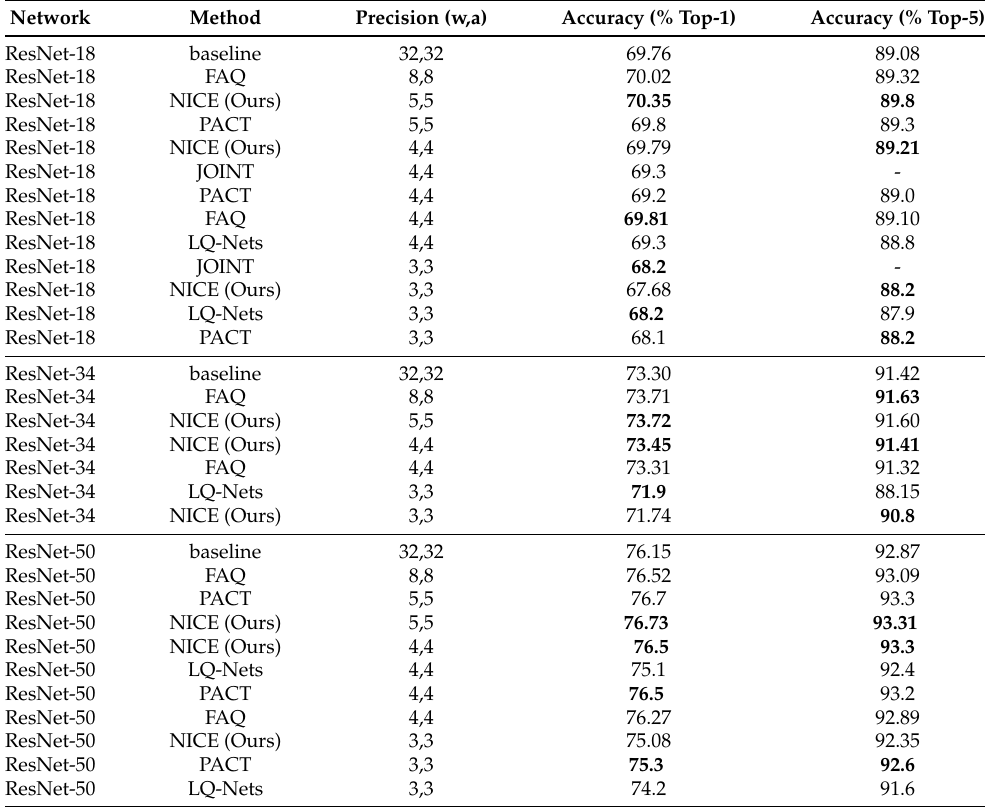
Table 2. ImageNet comparison. We report top-1, top-5 accuracy on ImageNet compared with state-of- the-art prior methods. For each DNN architecture, rows are sorted in number of bits. Baseline results were taken from PyTorch model zoo. Compared methods: JOINT [28], PACT [29], LQ-Nets [18], FAQ